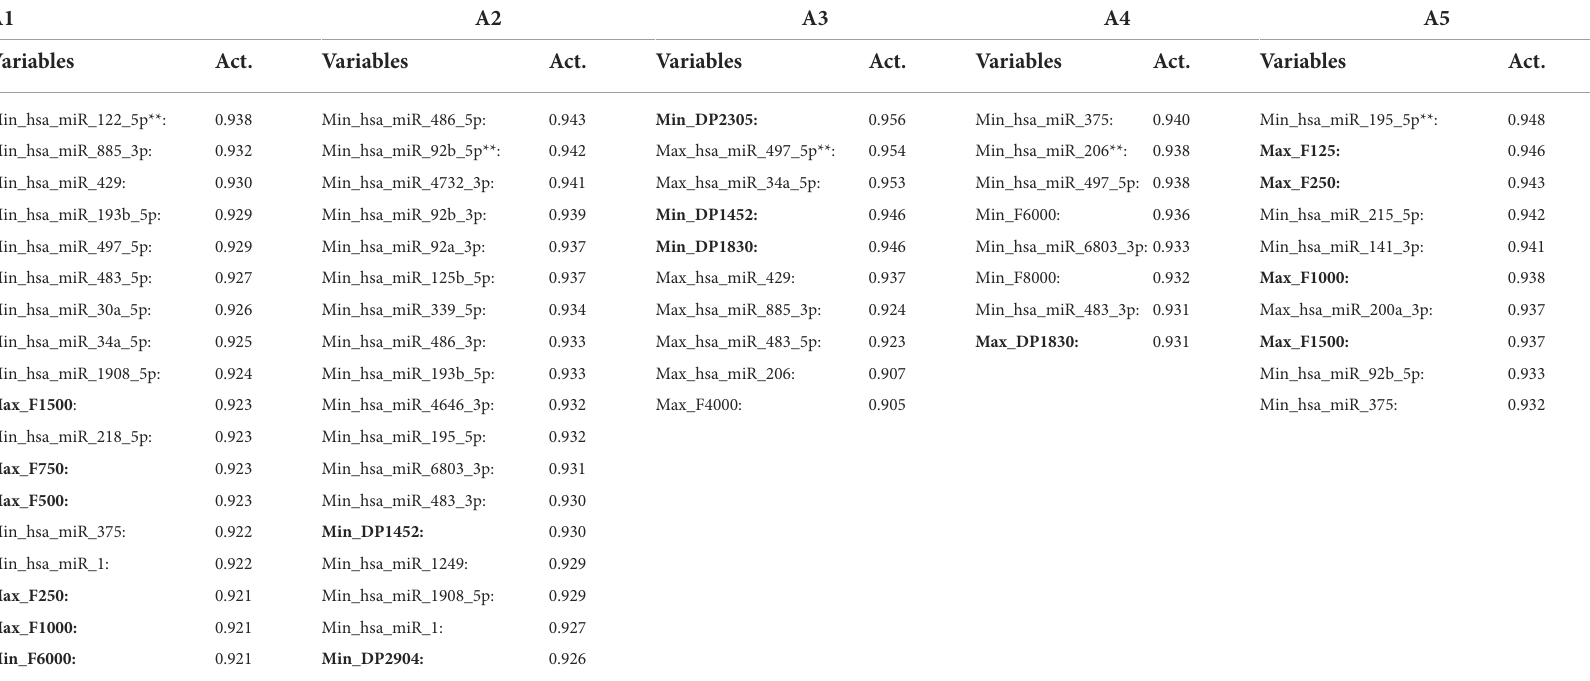
TABLE 3 The variables on which the query with Spin Net was carried out are marked with two asterisks (**): Min_has_miR_122-5p (A1), Min_hsa_miR_92b_5p (A2), Max_hsa_miR_497_5p (A3), Min_hsa_miR_206 (A4), and Min_hsa_miR_195_5p